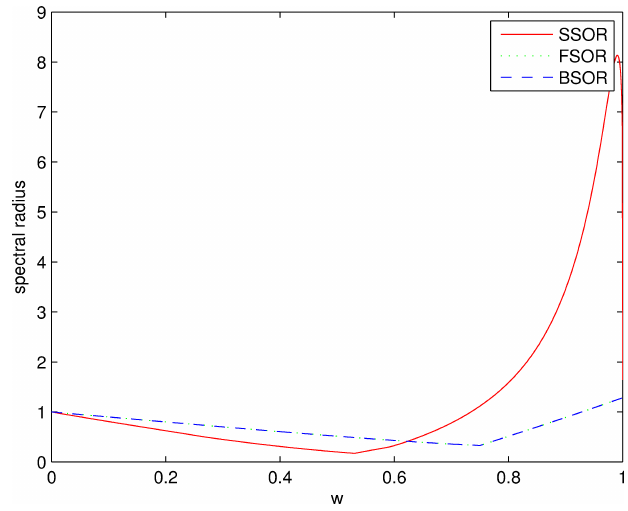
Fig. 1. The change of spectral radii of FSOR-, BSOR- and SSOR-iterative matrices with different !